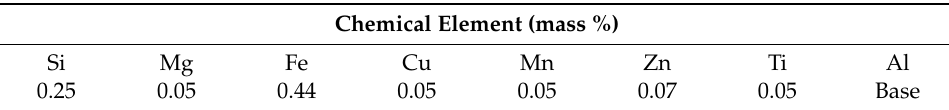
Table 1. Chemical composition of the Al alloy